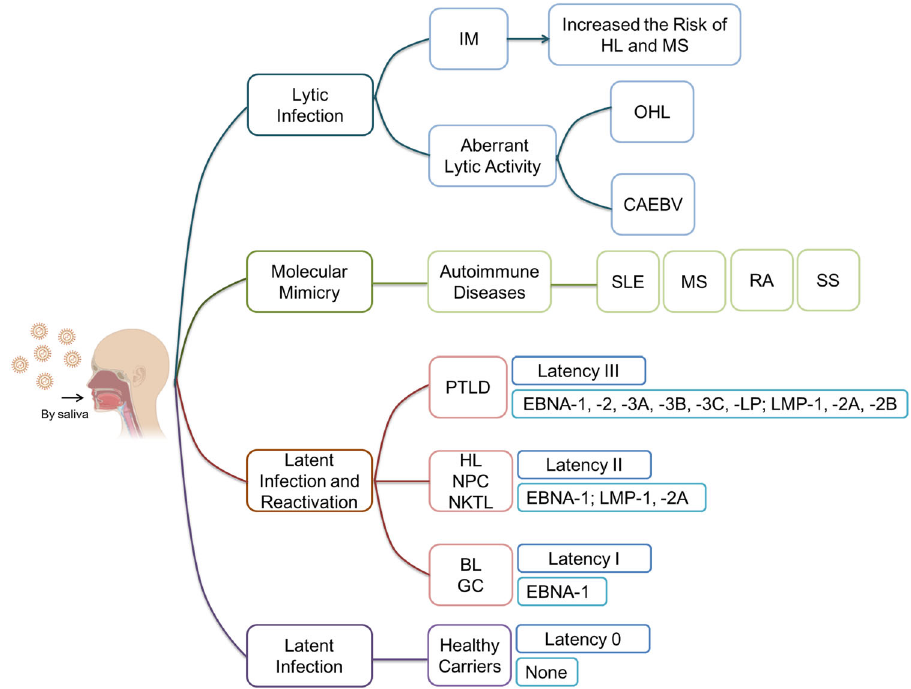
Fig. 1 EBV-associated diseases and latency states. Primary EBV infection can cause infectious mononucleosis (IM), which also increases the risk of Hodgkin ’ s lymphoma (HL) and multiple sclerosis (MS). EBV aberrant lytic activity is associated with oral hairy leukoplakia (OHL), chronic active EBV disease (CAEBV). EBV infection and reactivation cause several autoimmune diseases, including rheumatoid arthritis (RA), Sjögren ’ s syndrome (SS), systemic lupus erythematosus (SLE), and MS through molecular mimicry. Besides, EBV is tightly associated with various lymphomas, including Burkitt ’ s lymphoma (BL), HL, natural killer/T-cell lymphoma (NKTL), as well as epithelial malignancies such as gastric carcinoma (GC) and nasopharyngeal carcinoma (NPC). The EBV latency state in HL, NKTL, and NPC is type II, while BL and GC display EBV latency type I. Besides these cancers, EBV latency is also associated to lymphoproliferative diseases in patients after stem cell transplantation or solid organ transplantation (PTLD). The fi gure was made from